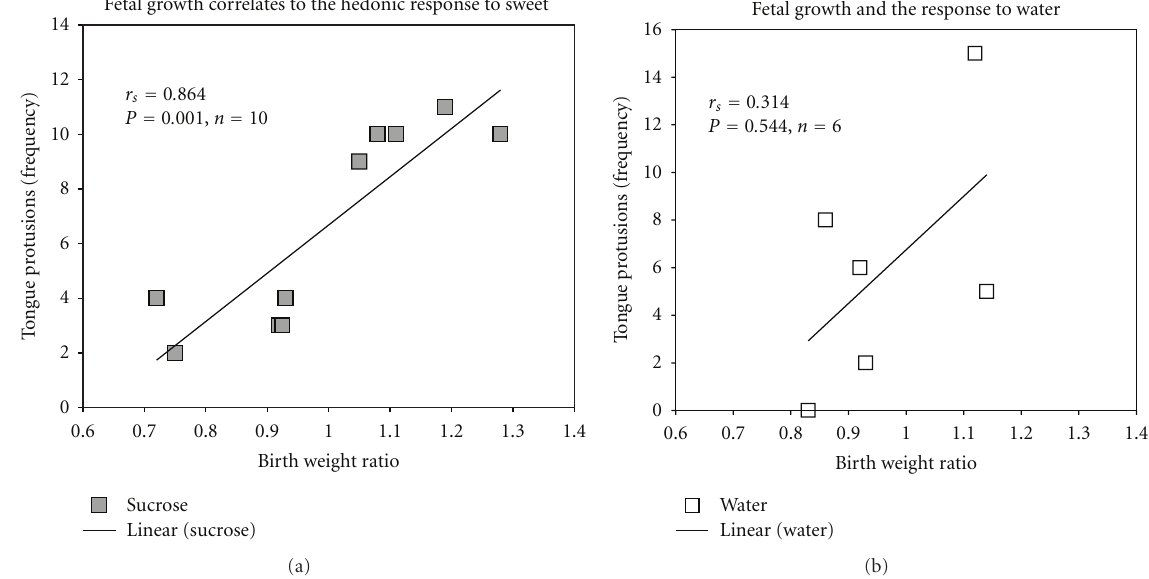
Figure 1: Correlations between birth weight ratio and the frequency of tongue protrusions (hedonic response) to (a) sucrose and (b) water.